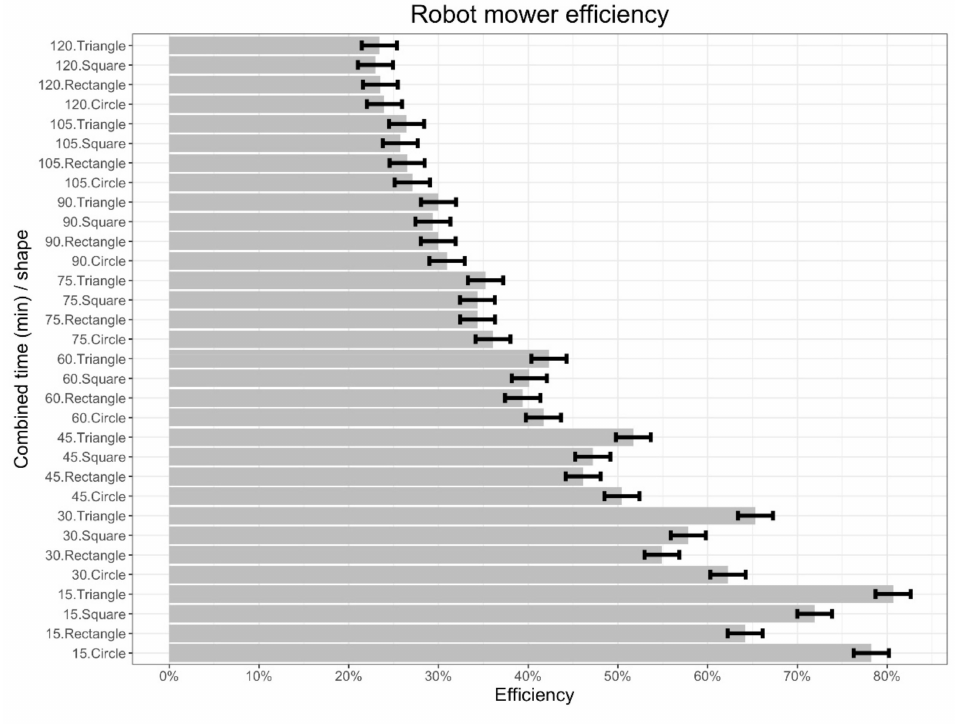
Figure 9. Means and 95% confidence intervals of the e ffi ciency of the robot mower in the four turfgrass area shapes at 15, 30, 45, 60, 75, 90, 105, and 120 min from the start of the